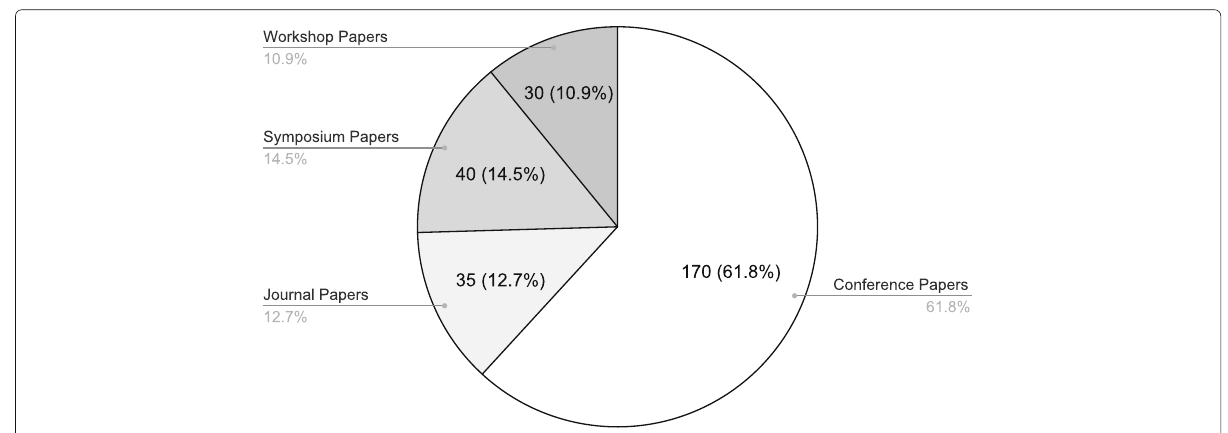
Fig. 4 Published papers ratio per each